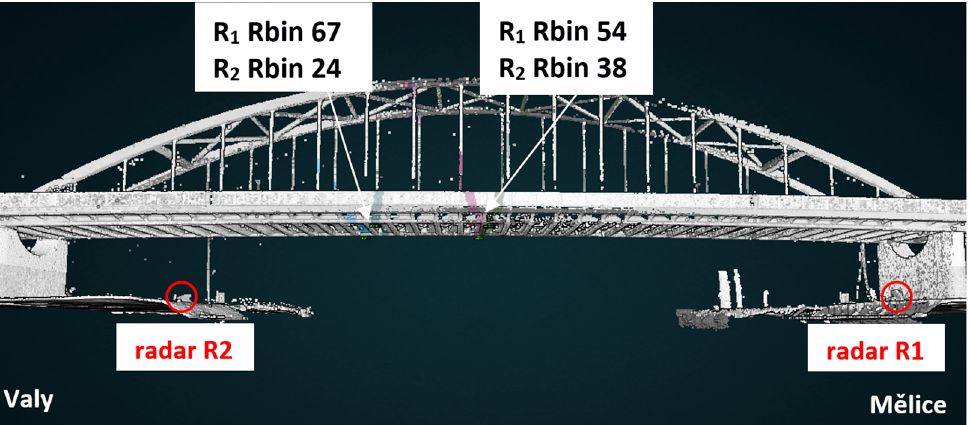
Figure 16. Three-dimensional model of the bridge with color-highlighted R bin s for radars R1 and R2, which were evaluated.